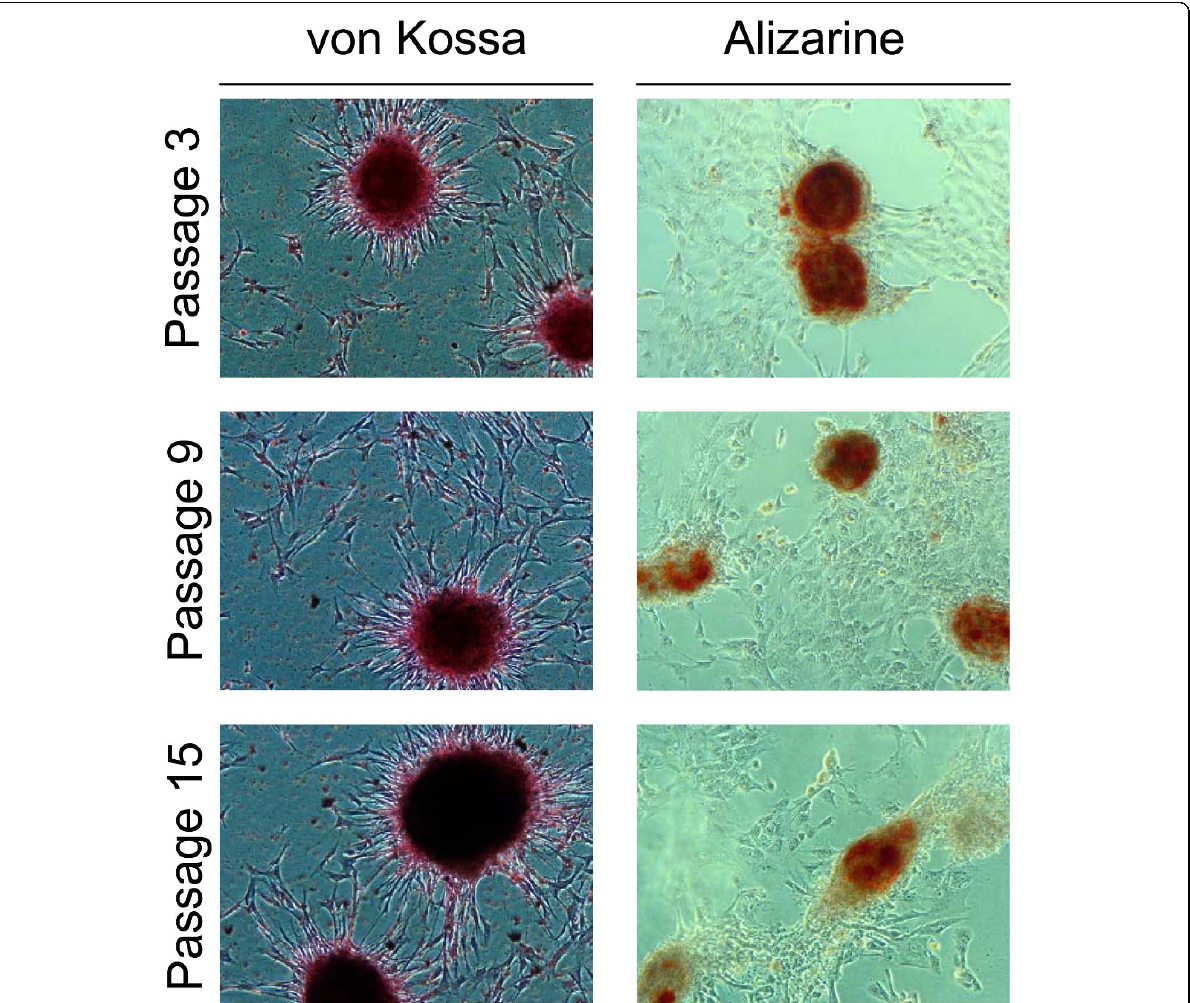
Figure 4 Viral transduction of EADSCs maintains differentiation properties . Representative images (20×) of von Kossa and alizarin stained differentiated EADSCs at different passages (3, 9 and 15) post lentiviral